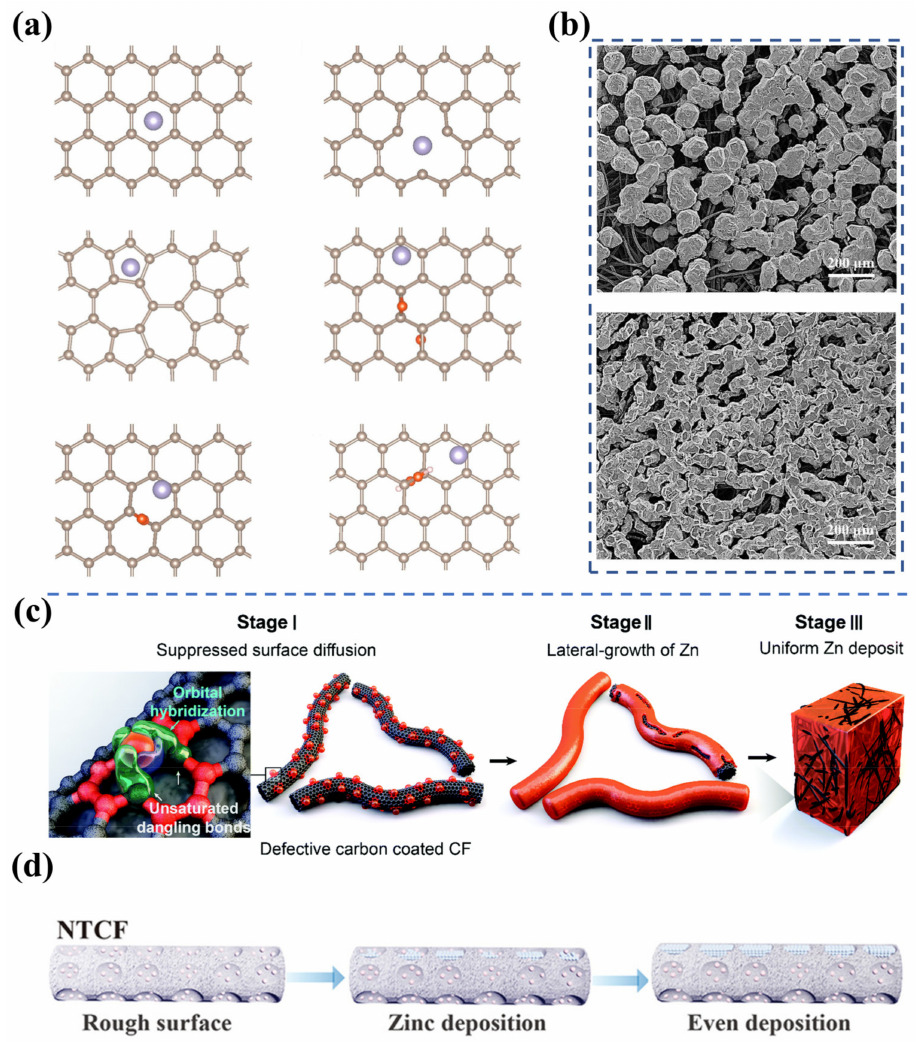
Figure 3. ( a ) The most stable structural morphologies of Zn atoms adsorbed on the original graphite (0001) surface, and surfaces with single vacancy, double vacancy, and oxygen functional groups. ( b ) SEM images of Zn deposition on pristine graphite felt (above) and heat-treated graphite felt (below) near the membrane side after charging. (Reproduced from [20] with permission from Elsevier.) ( c ) Schematic diagram for uniform Zn nucleation and growth on the defective layer coated electrode. (Reproduced from [21] with permission from Royal Society of Chemistry.) ( d ) The process of Zn deposition on the carbon felts with nitrogen-rich defects during battery charging. (Reproduced from [42] with permission from